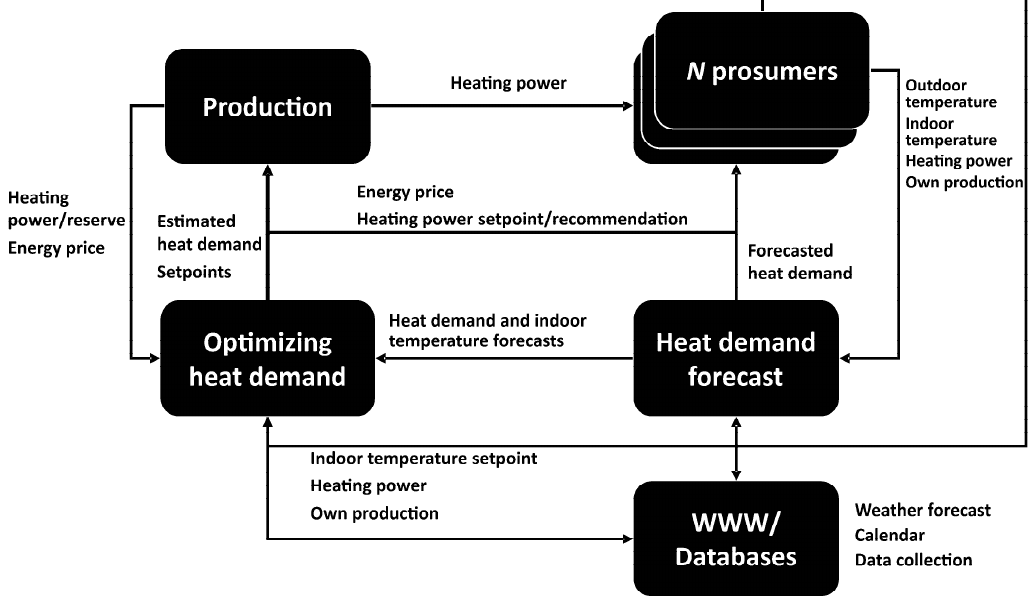
Figure 7. The concept for cutting the peak loads and optimizing the heat demand.